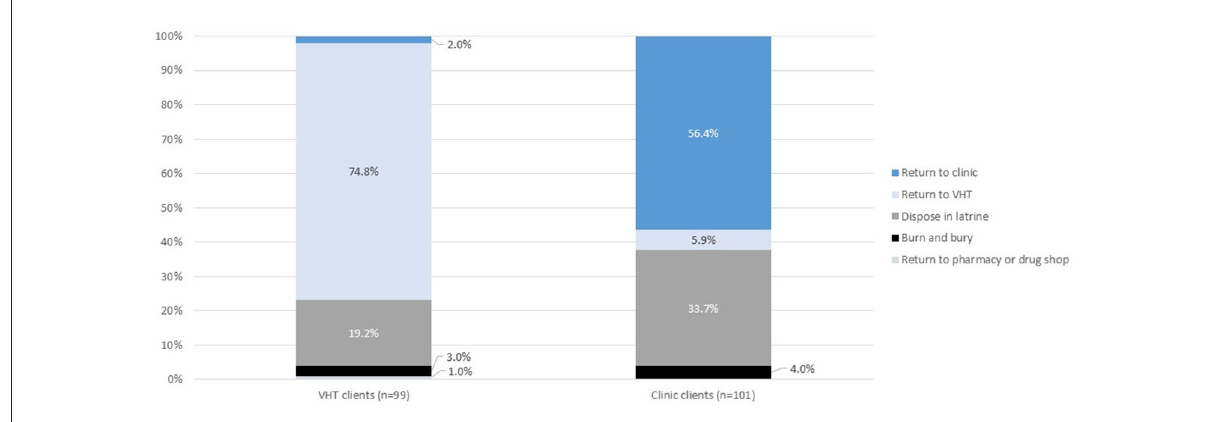
FIGURE4 Disposal preferences by training location (clinic or community).